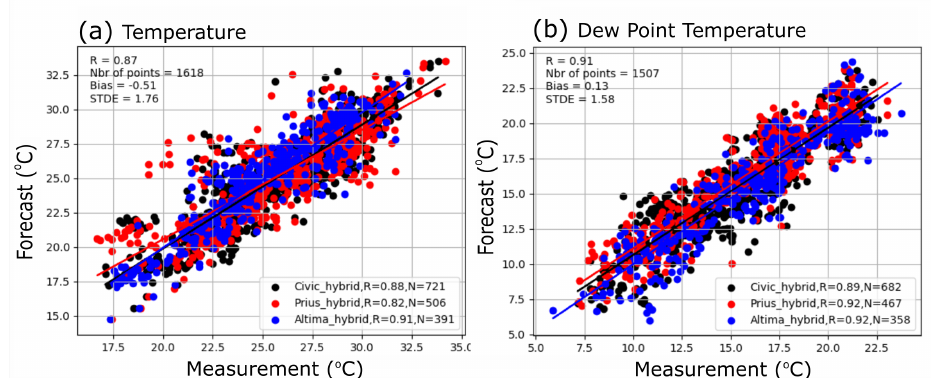
Figure 15. Scatter plots of the predicted versus measured 2-m air temperature ( a ) and dew point temperature ( b ) for the AMMOS mobile measurements and the corresponding model grid